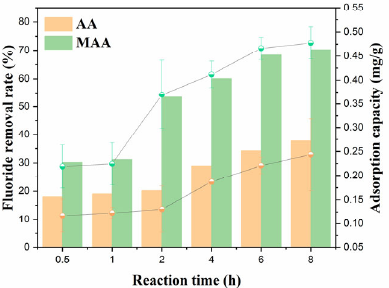
Figure 8. Comparison of fluoride removal effect on fresh AA and MAA in real contaminated water. Reaction conditions: [Fluoride concentration] 0 = 4.5 mg/L, [Adsorbent dosage] = 7 g/L, pH 0 = 4.18 and T = 298